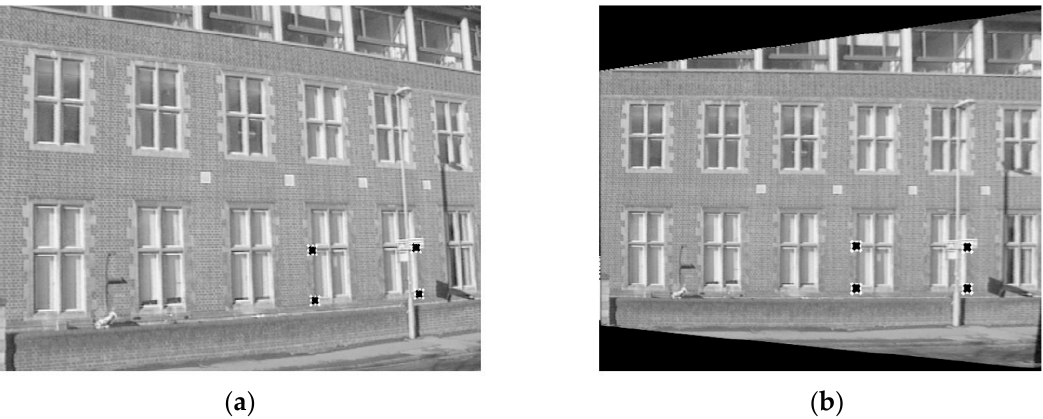
Figure 6. A projective transformation is de fi ned by four points on the scene plane: ( a ) any four points arbitrary view of an environment’s image, and ( b ) four points in the frontal view after using a projective transformation.